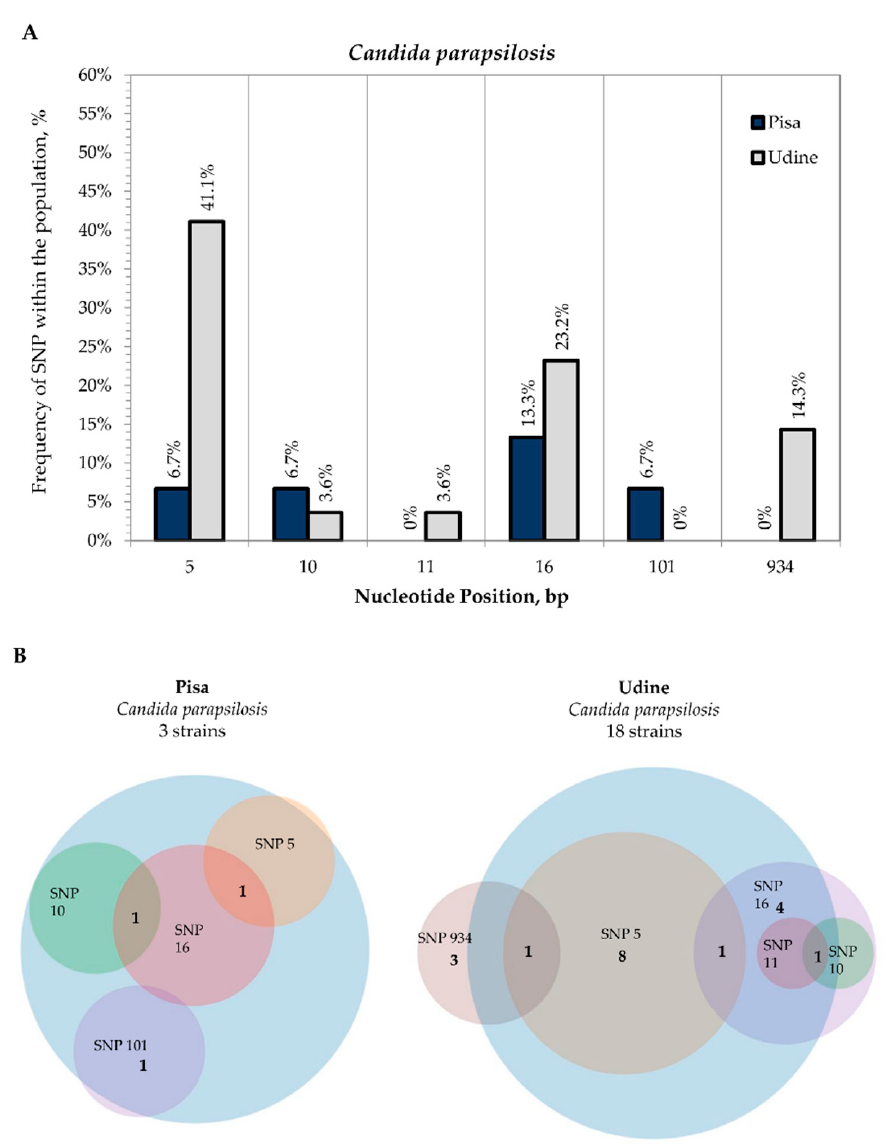
Figure 6. Internal variability of C. parapsilosis species (SNPs). Legend. Internal variability of C. parapsilosis species (SNPs). ( A ): Frequency of SNPs within the population ( y -axis) vs. nucleotide position ( x -axis). For both sampling sites, SNP frequencies were calculated on the basis of the coverage in the multiple sequence alignment of all the second-level consensus sequences with the type strain. Frequencies of SNPs from Pisa Hospital (blue columns) and Udine Hospital (grey columns). ( B ): Venn diagrams of strains isolated from Pisa Hospital and Udine Hospital that displayed the presence of SNPs.